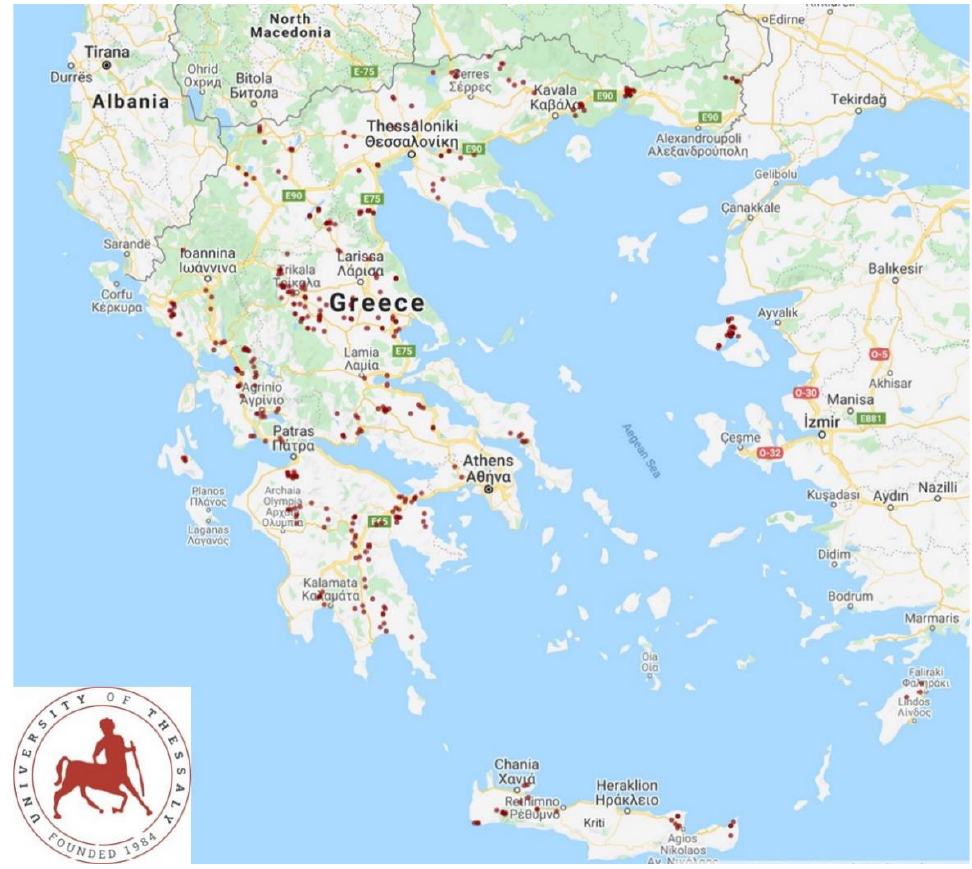
Figure 1. Map showing the locations of the 325 sheep flocks and 119 goat herds throughout Greece, which were visited to collect data and information on vaccination schedules and procedures.